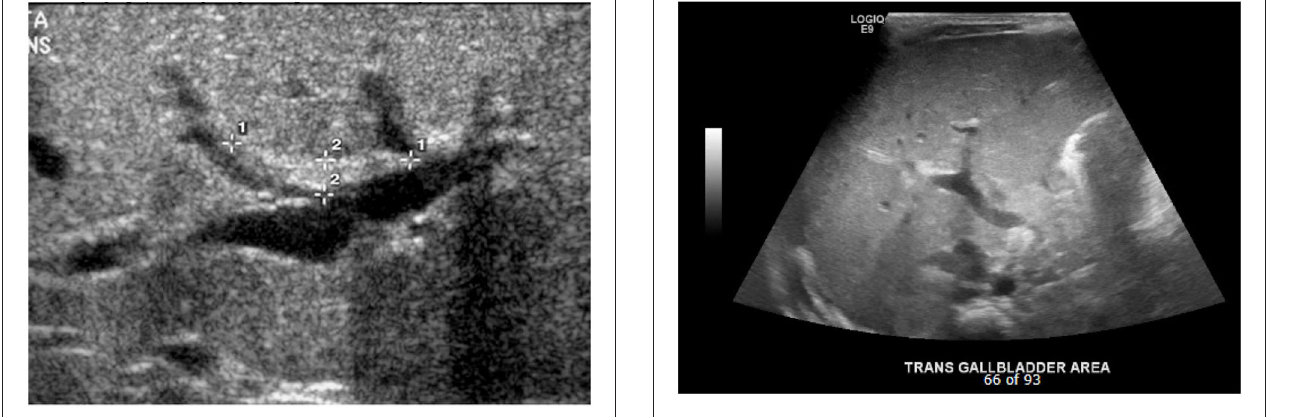
FIGURE 1 | The triangular cord sign.